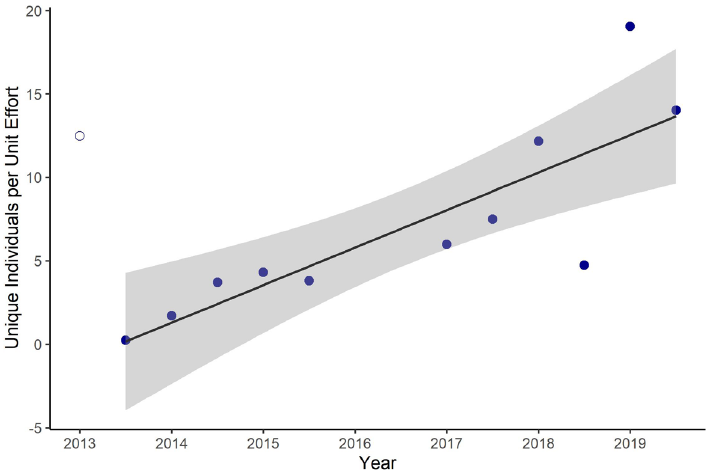
Figure 4. Trend in winter and spring unique individuals per unit effort estimated using a generalized linear model. Shading represents 95% confidence interval around the trend line. The open circle is an outlier that was removed from the analyses prior to fitting the trend line shown here (see text for